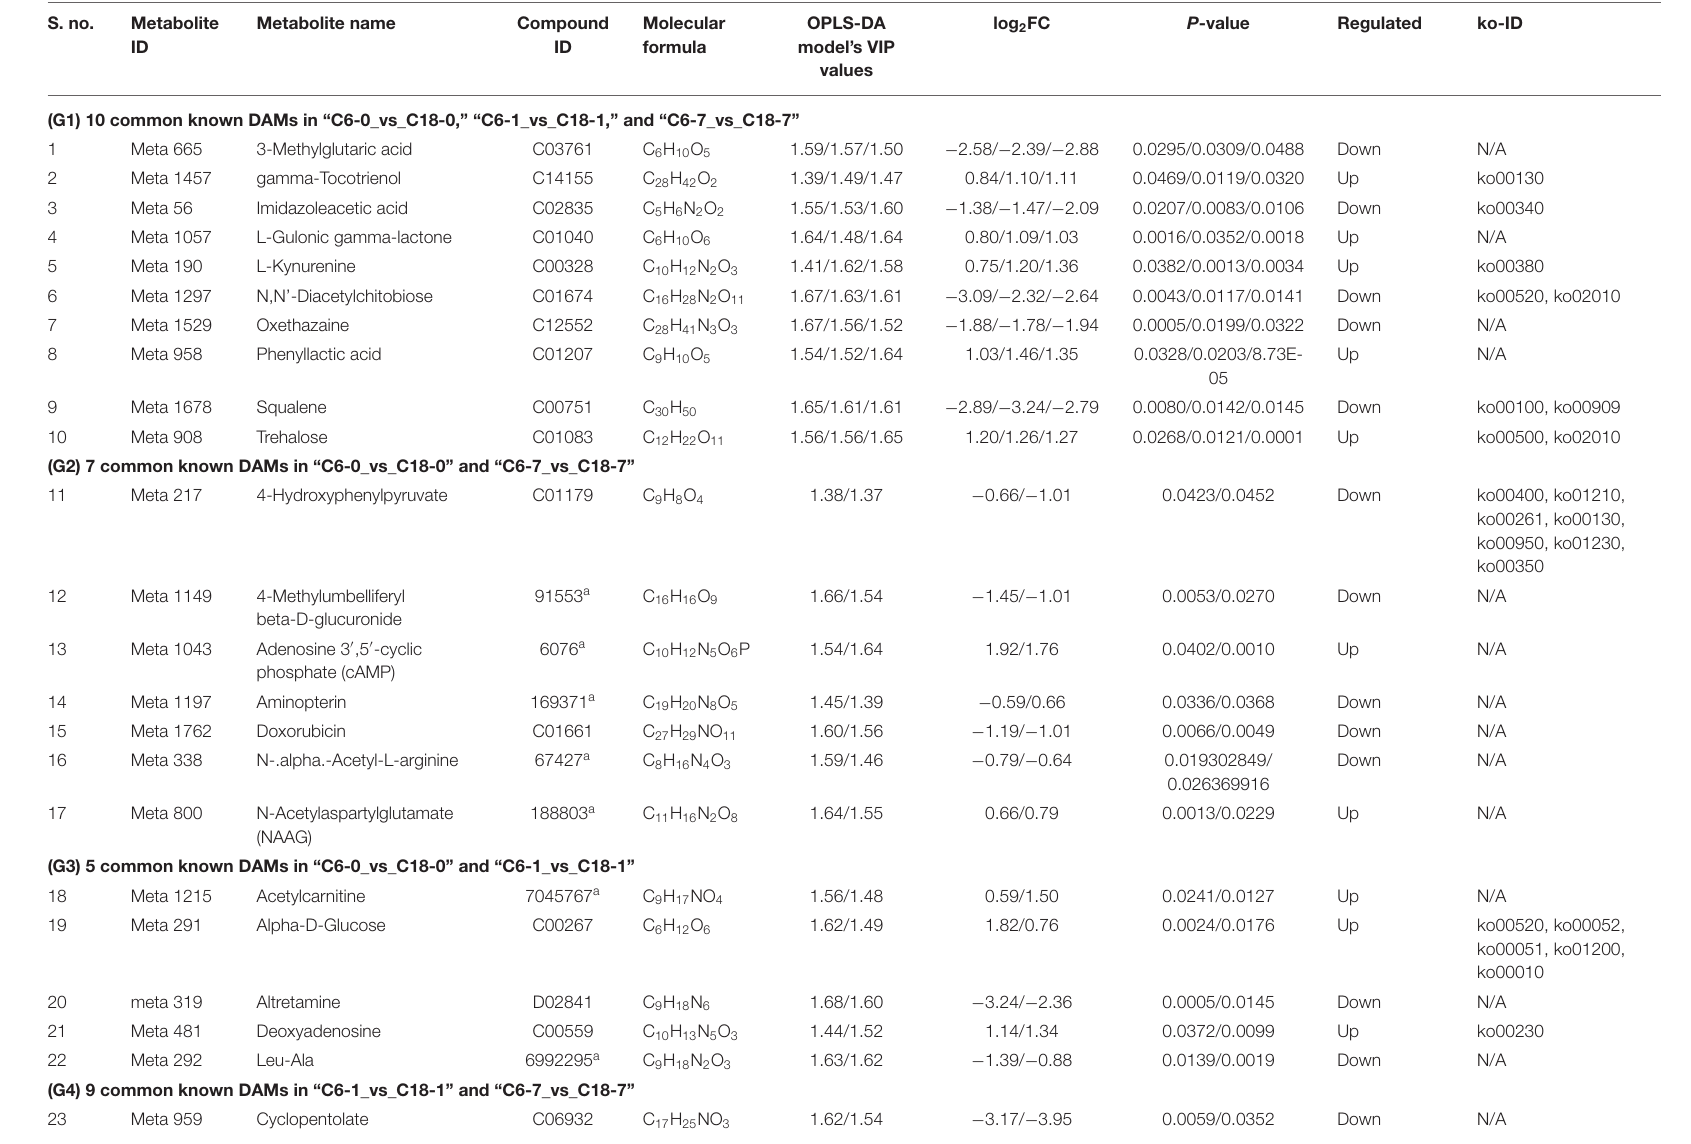
TABLE 1 | Information about important known DAMs with their compound ID, molecular formula, log 2 FC values, p -values, and type of regulations along with ko-ID identified by OPLS-DA model. S.